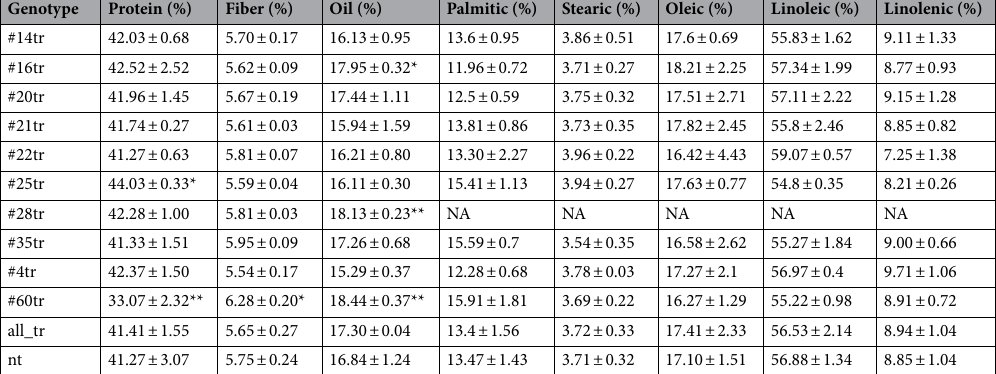
Table 1. Effect of ZmSOC1 expression on seed quality. Protein, fiber and oil contents were measured using a Grain Analyzer. Fatty acids were determined by gas chromatography. The mean value (± STDEV) for each transgenic and nontransgenic (NT) line, were for the seeds from 2–4 transgenic plants except that all_tr is the average of all transgenic lines. Each transgenic line and all_tr were compared with the nt. NA not available. Signif. codes: *** P < 0.001, ** P < 0.01, and * P <